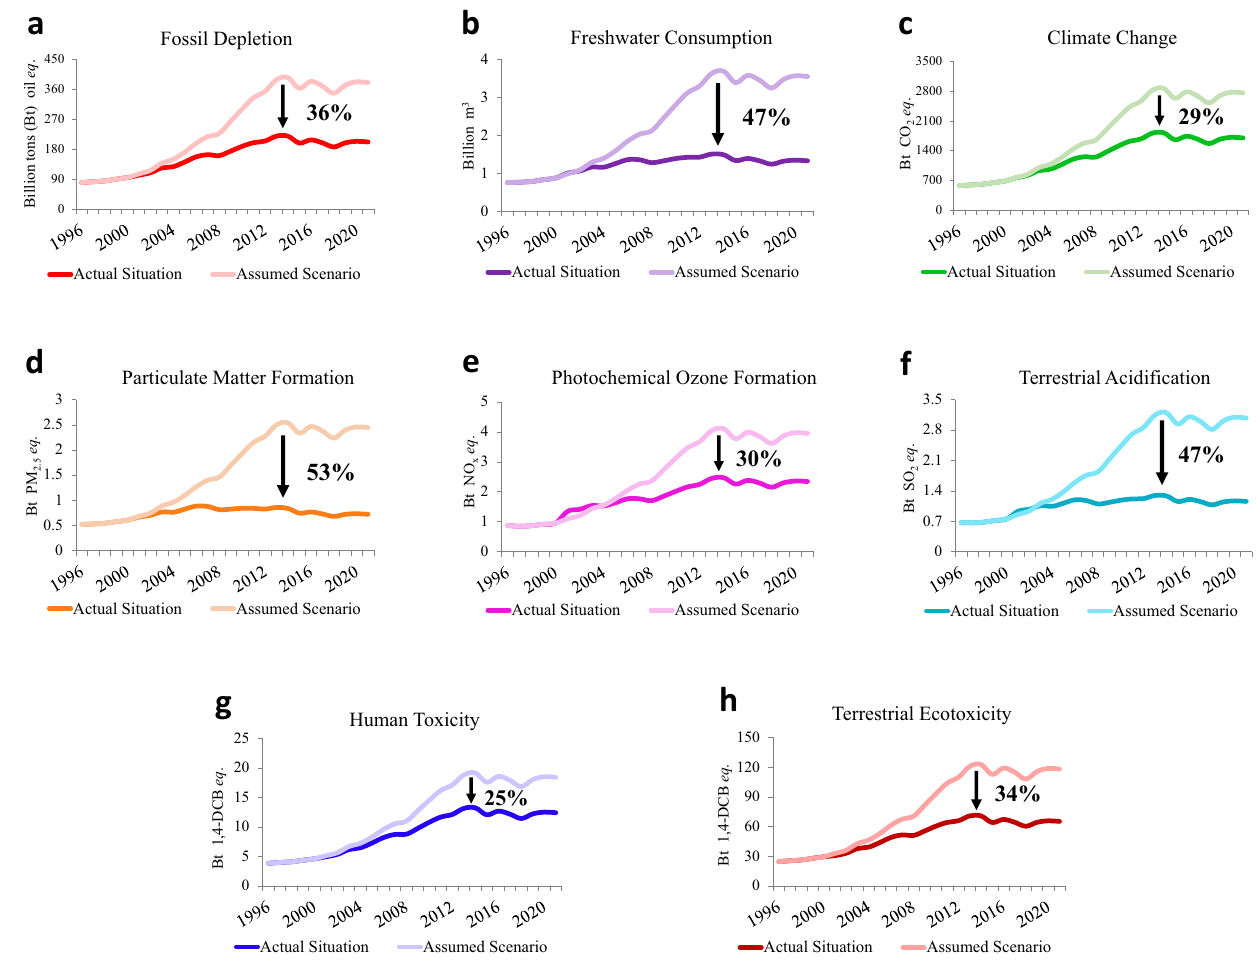
Fig. 3 Environmental gains of China ’ s cement manufacturing technology upgrading from 1996 to 2021. a – h compare the environmental impacts of cement manufacturing in China under two situations: the “ Actual Situation ” and the “ Assumed Scenario" (if CMT upgrading had not taken place). The percentages noted in Fig. 3 are the cumulative reduction in environmental impacts from 1996 to 2021.